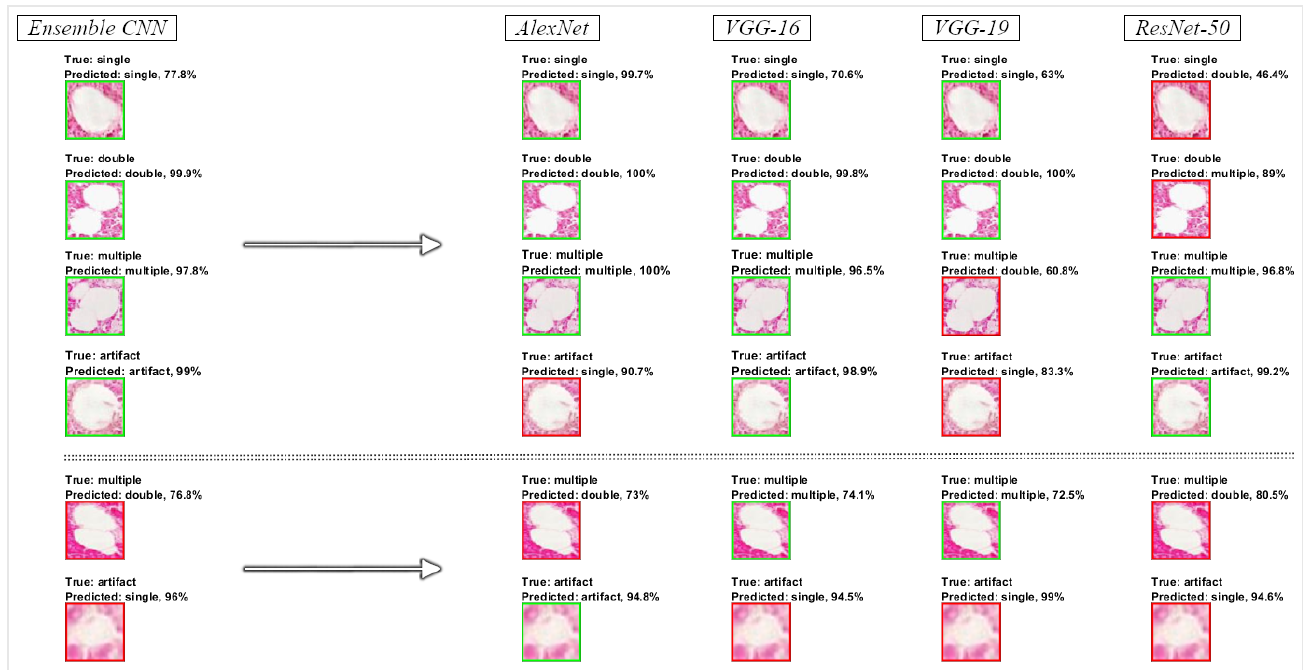
Figure 8. Display of classification wins (green borders) and losses (red borders) for all CNN ap- proaches. The ensemble CNN’s voting system takes into account the majority of predicted pancreatic classes from the individual AlexNet, VGG-16, VGG-19, and ResNet-50 architectures along with the estimated softmax probability